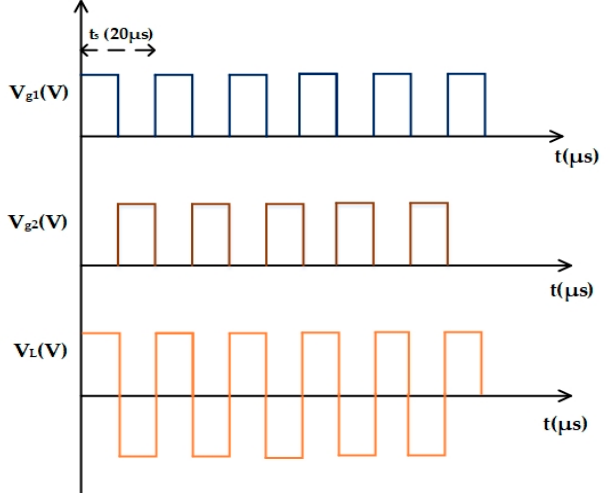
Figure 8. Pulses and load voltage waveforms for non-ferrous heating mode.